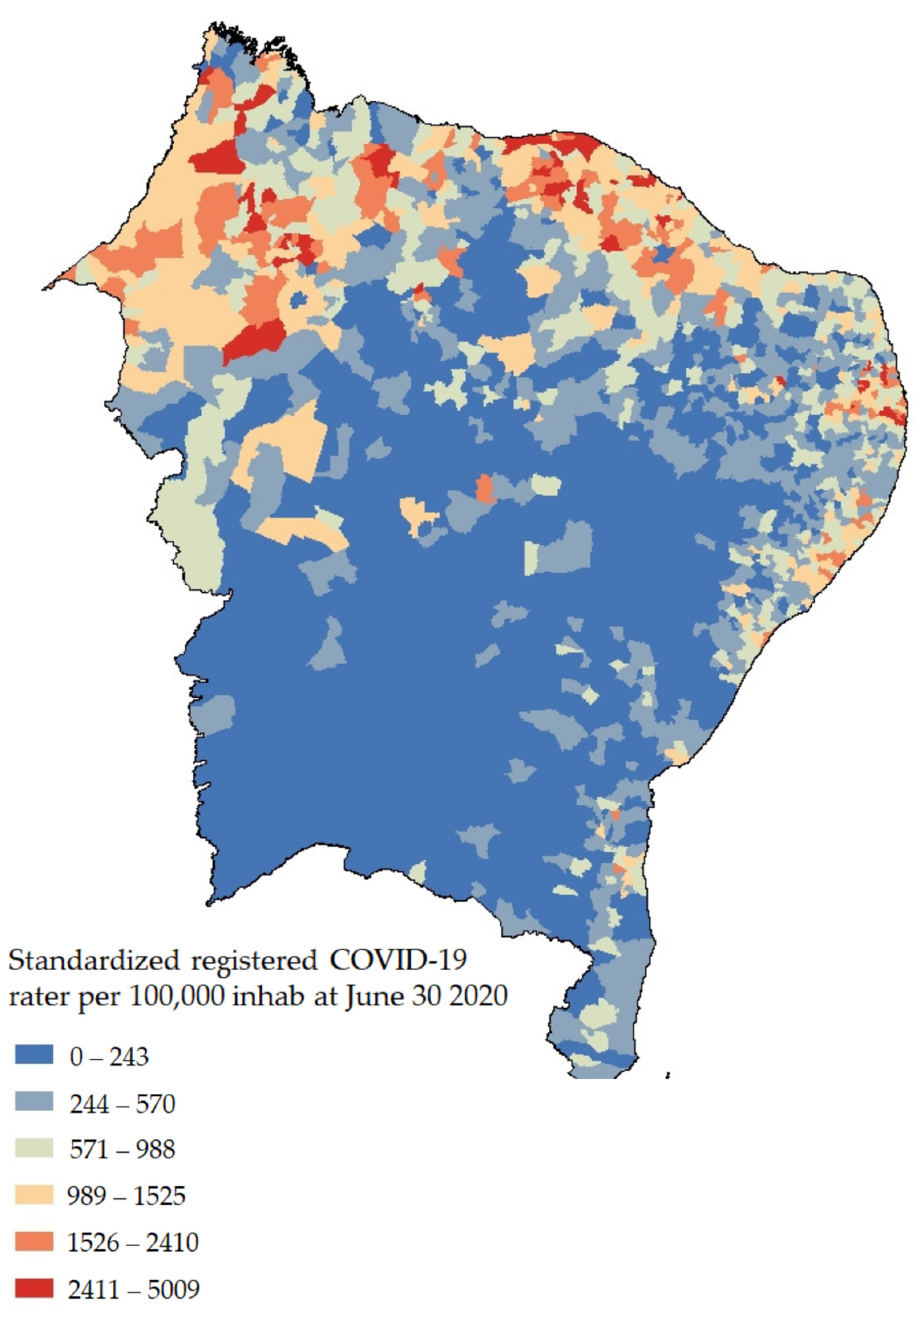
Figure 2. Natural breaks for COVID-19 cases for 30 June 2020.